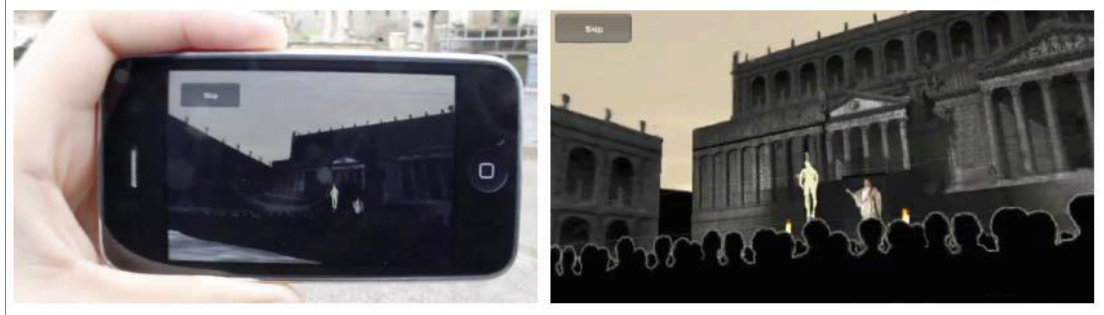
Figure 8 Roll- back in time. Crowd, Mark Antony’s Speech (Liestøl, 2011)